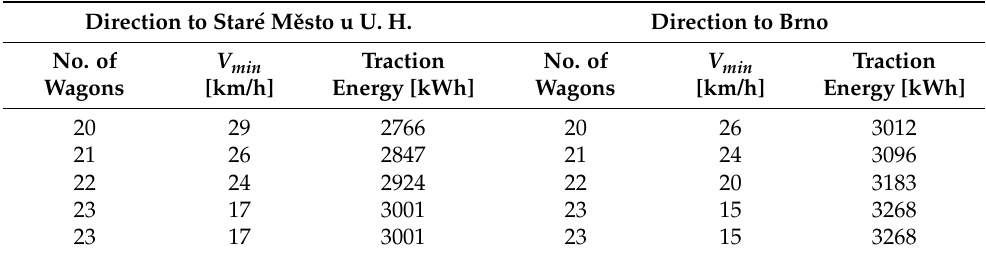
Table 11. Sensitivity analysis for the model train with Siemens locomotive on the line 340.